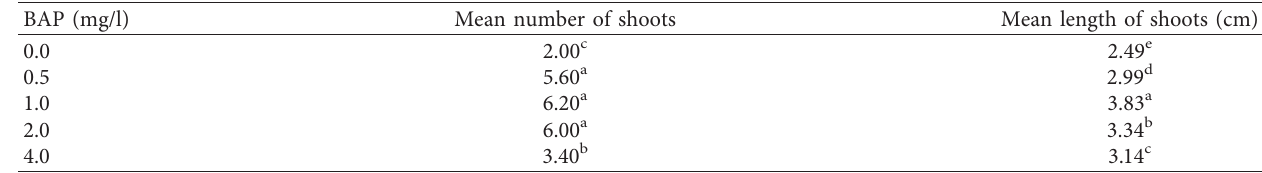
Table 2: The growth of shoots under BAP treatments.